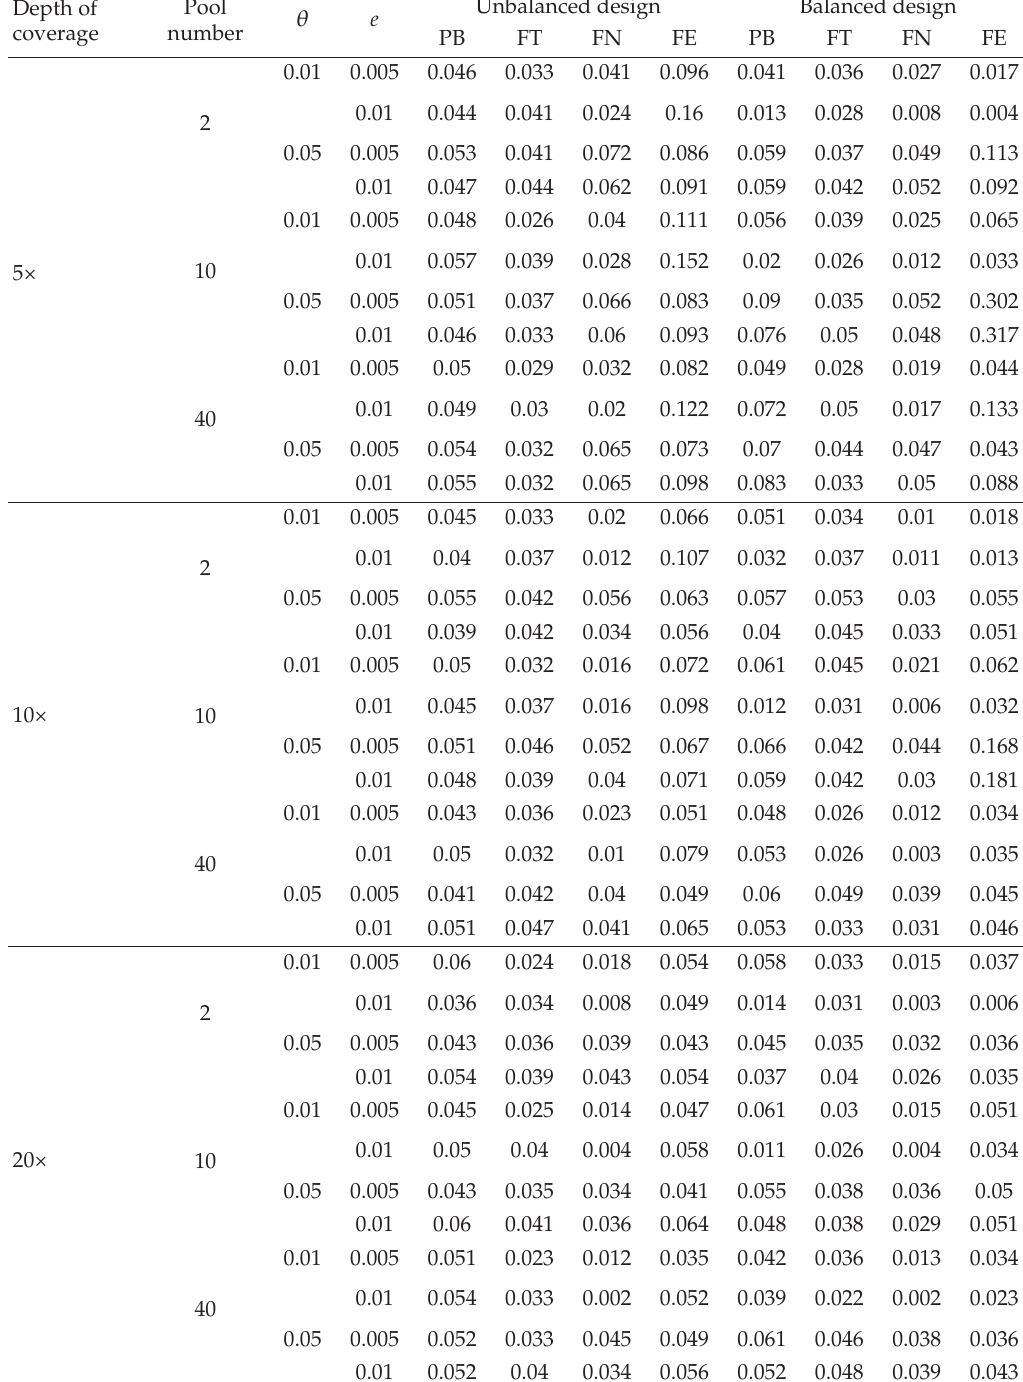
Table 2: Type I error rates at a level of 5% for the PB test and Fisher’s exact tests under various depths of coverage, numbers of pools, allele frequencies, and the error rates for testing association. Sample size was set at 500 cases and 500